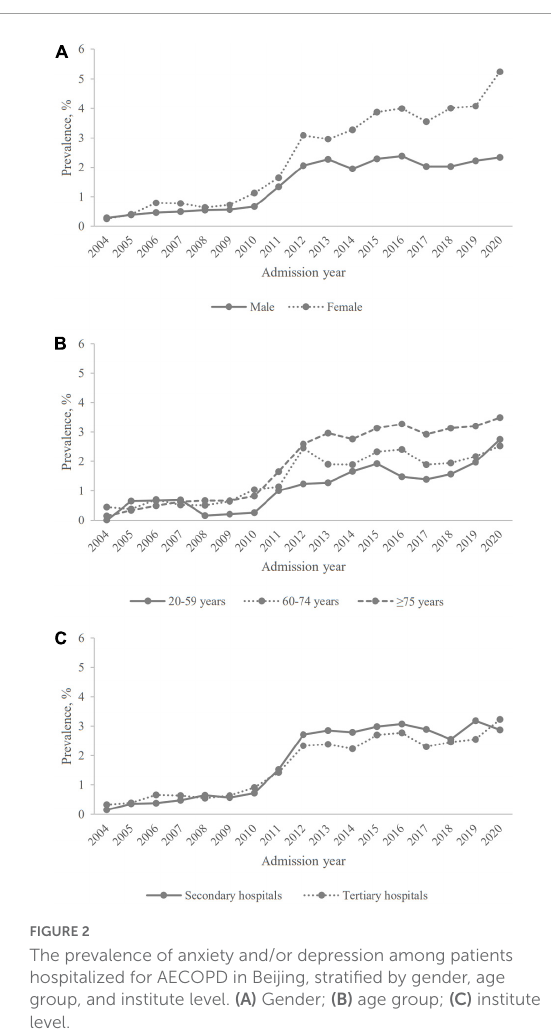
FIGURE2 The prevalence of anxiety and/or depression among patients hospitalized for AECOPD in Beijing, stratified by gender, age group, and institute level. (A) Gender; (B) age group; (C) institute